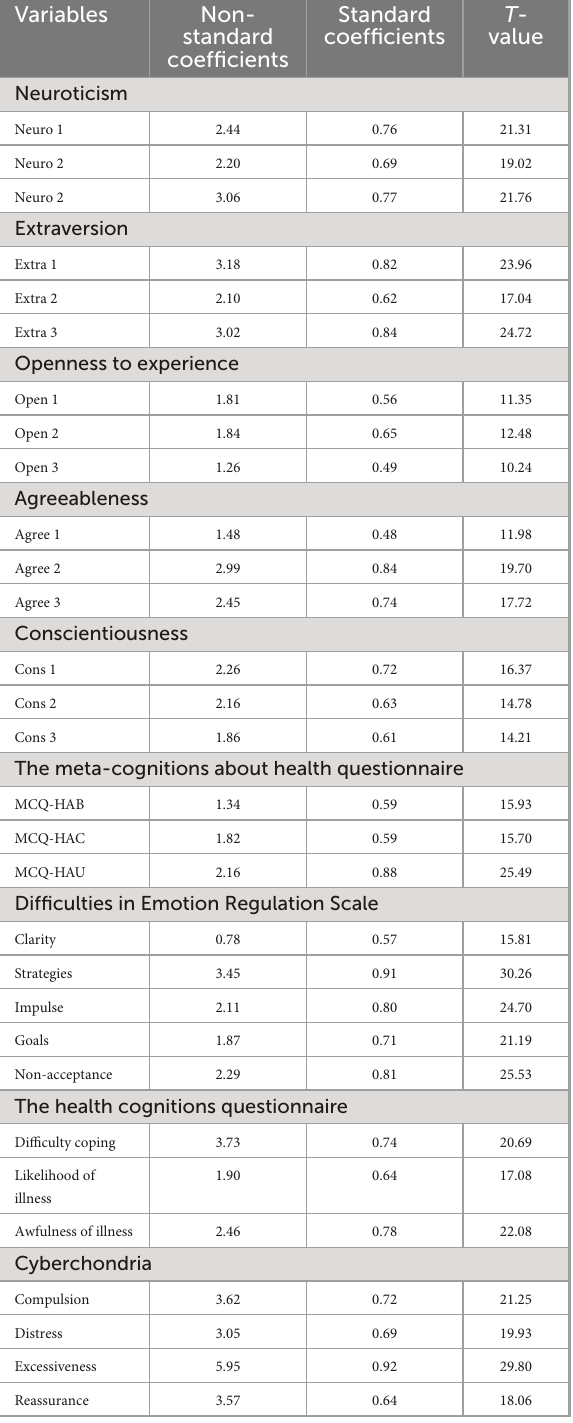
TABLE 2 Standard coefficients, Non-standard coefficients, and T -values of the observable variables in the measurement model.